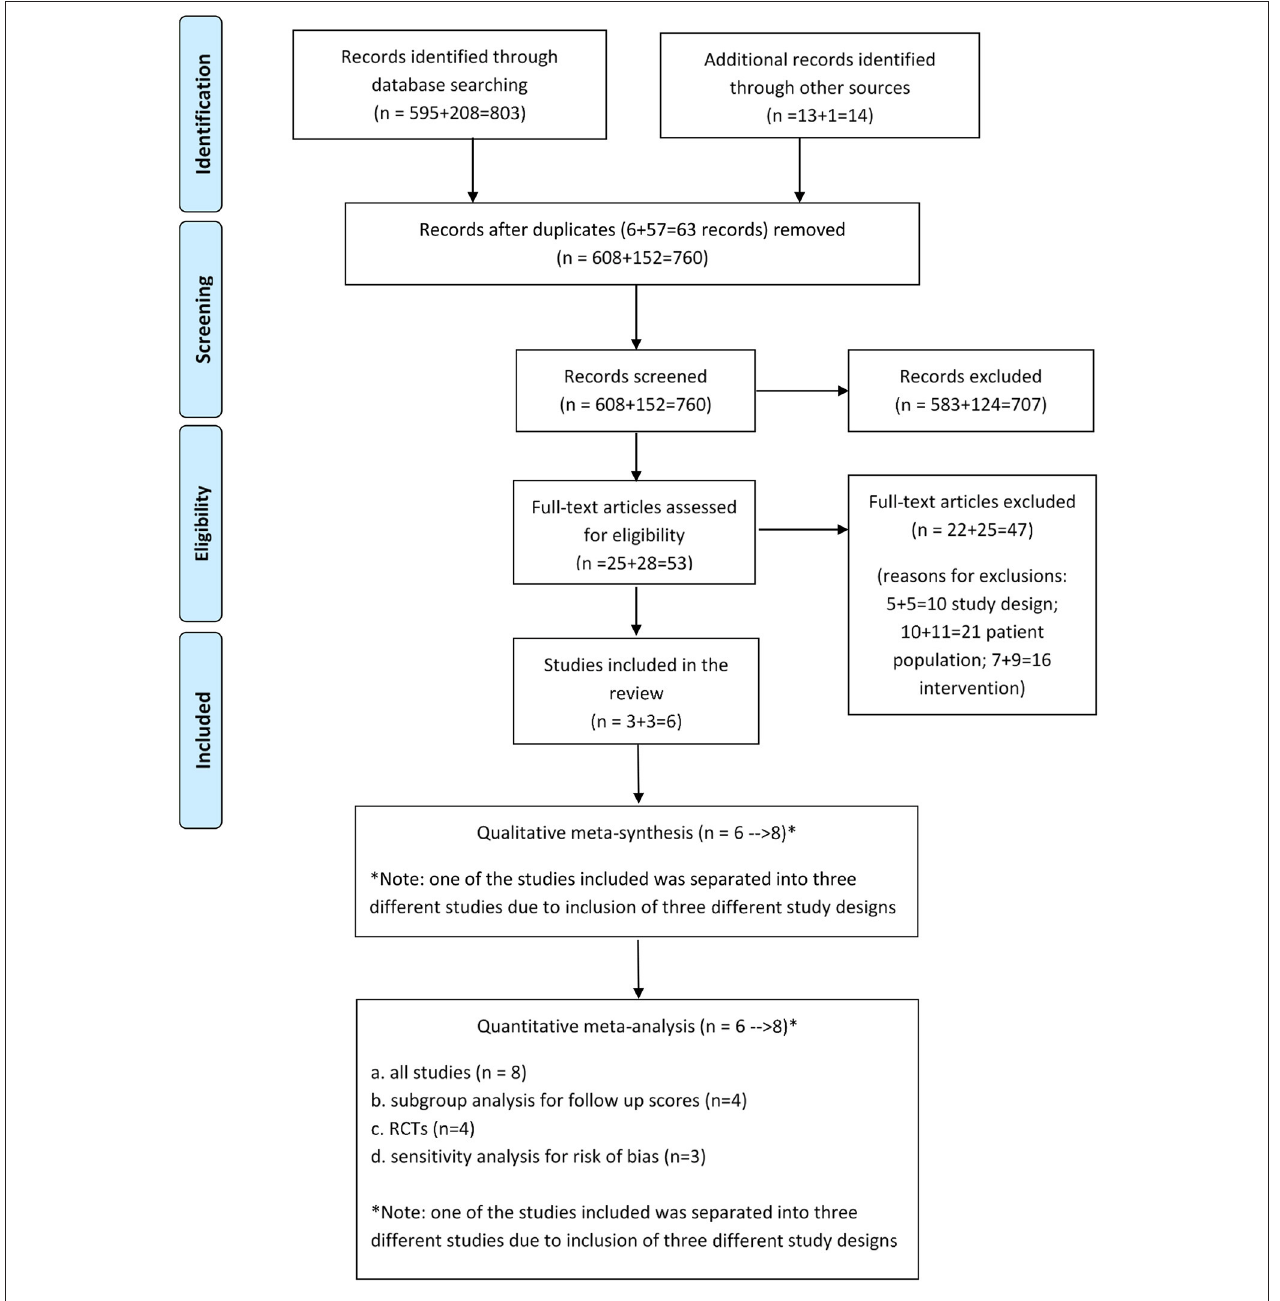
FIGURE 2 | PRISMA 2009 flow